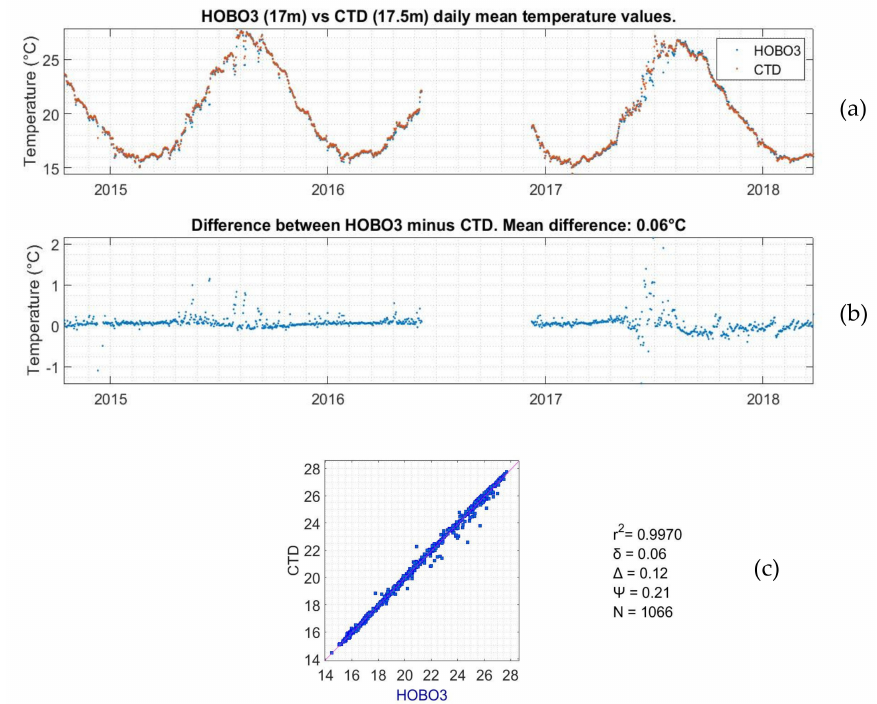
Figure 3. ( a ) Data series of the CTD instrument (accompanied by a calibration certificate) compared to the data series of the HOBO3 logger (no calibration certificate). Both sensors are deployed at almost 17 m below the sea surface. Data points are the daily averaged values of each sensor. ( b ) Di ff erence between the HOBO3 minus the CTD daily averaged data. For the interruption between June 2016 and December 2016, refer to Table A1. ( c ) Correlation plot and statistics (refer to Section 2.4 for definitions) for the comparison between the HOBO3 and CTD